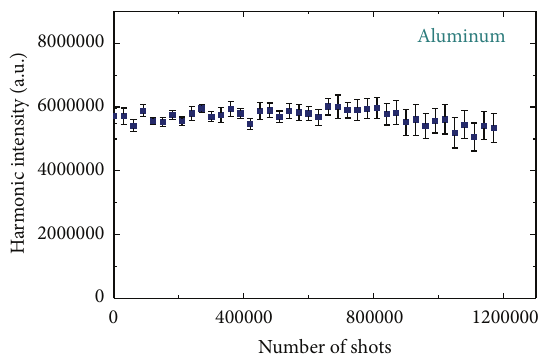
Figure 8: Stability of integrated harmonic signal from the alu- minum plasma in the case of rotating target